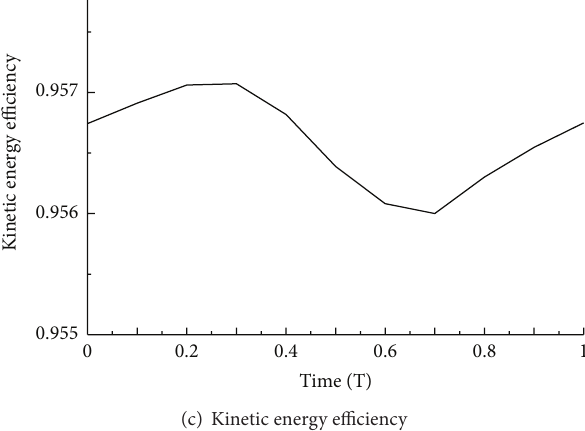
(c) Kinetic energy efficiency Figure 15: Flow performance of Rampressor inlet in a whirling motion cycle.